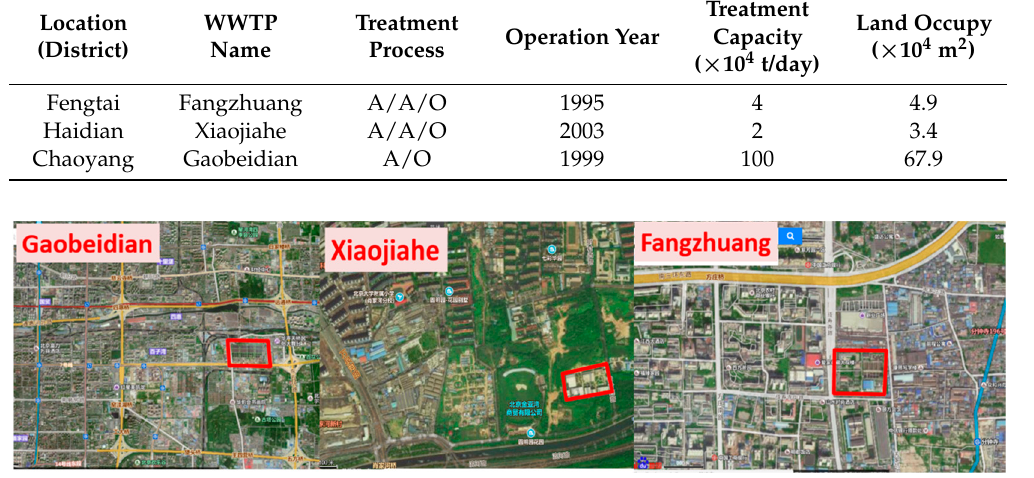
Figure 1. Aerial images of Gaobeidian, Xiajiahe and Fangzhuang WWTPs in Beijing (red line indicates boundary of WWTPs).